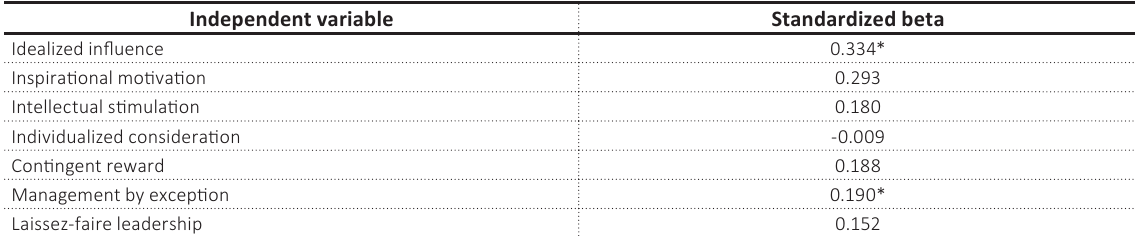
Table 8. Regression results between the dimensions of leadership style and organizational